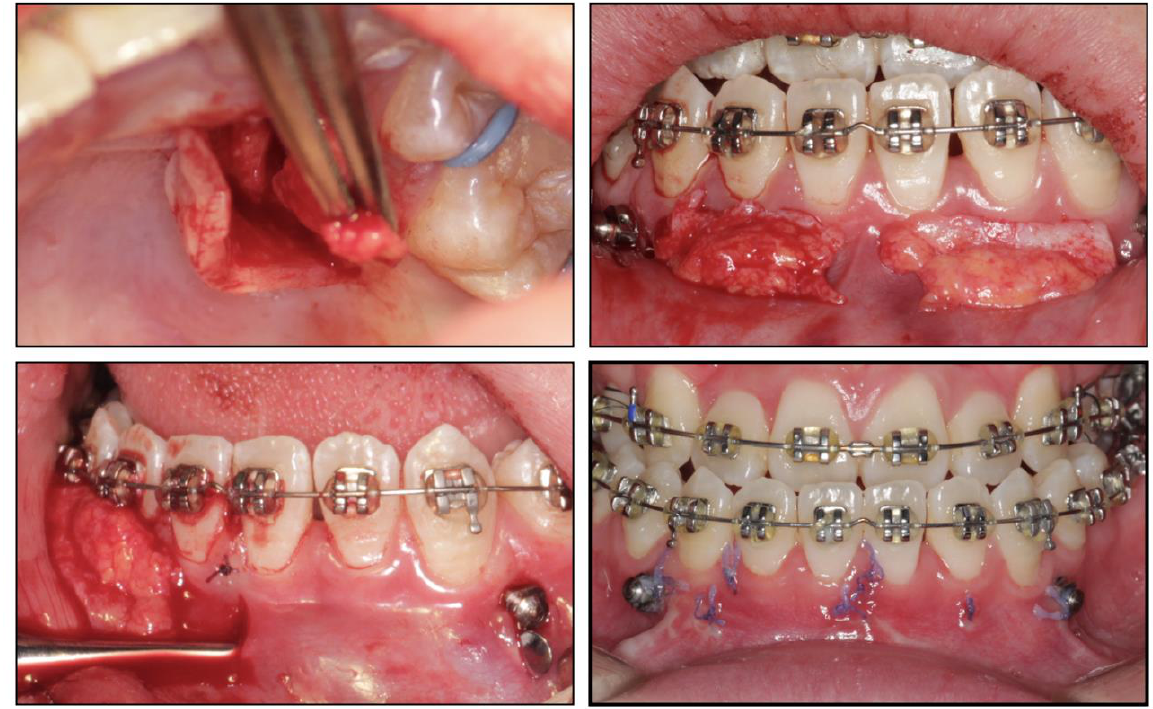
Figure 5. Subepithelial connective tissue